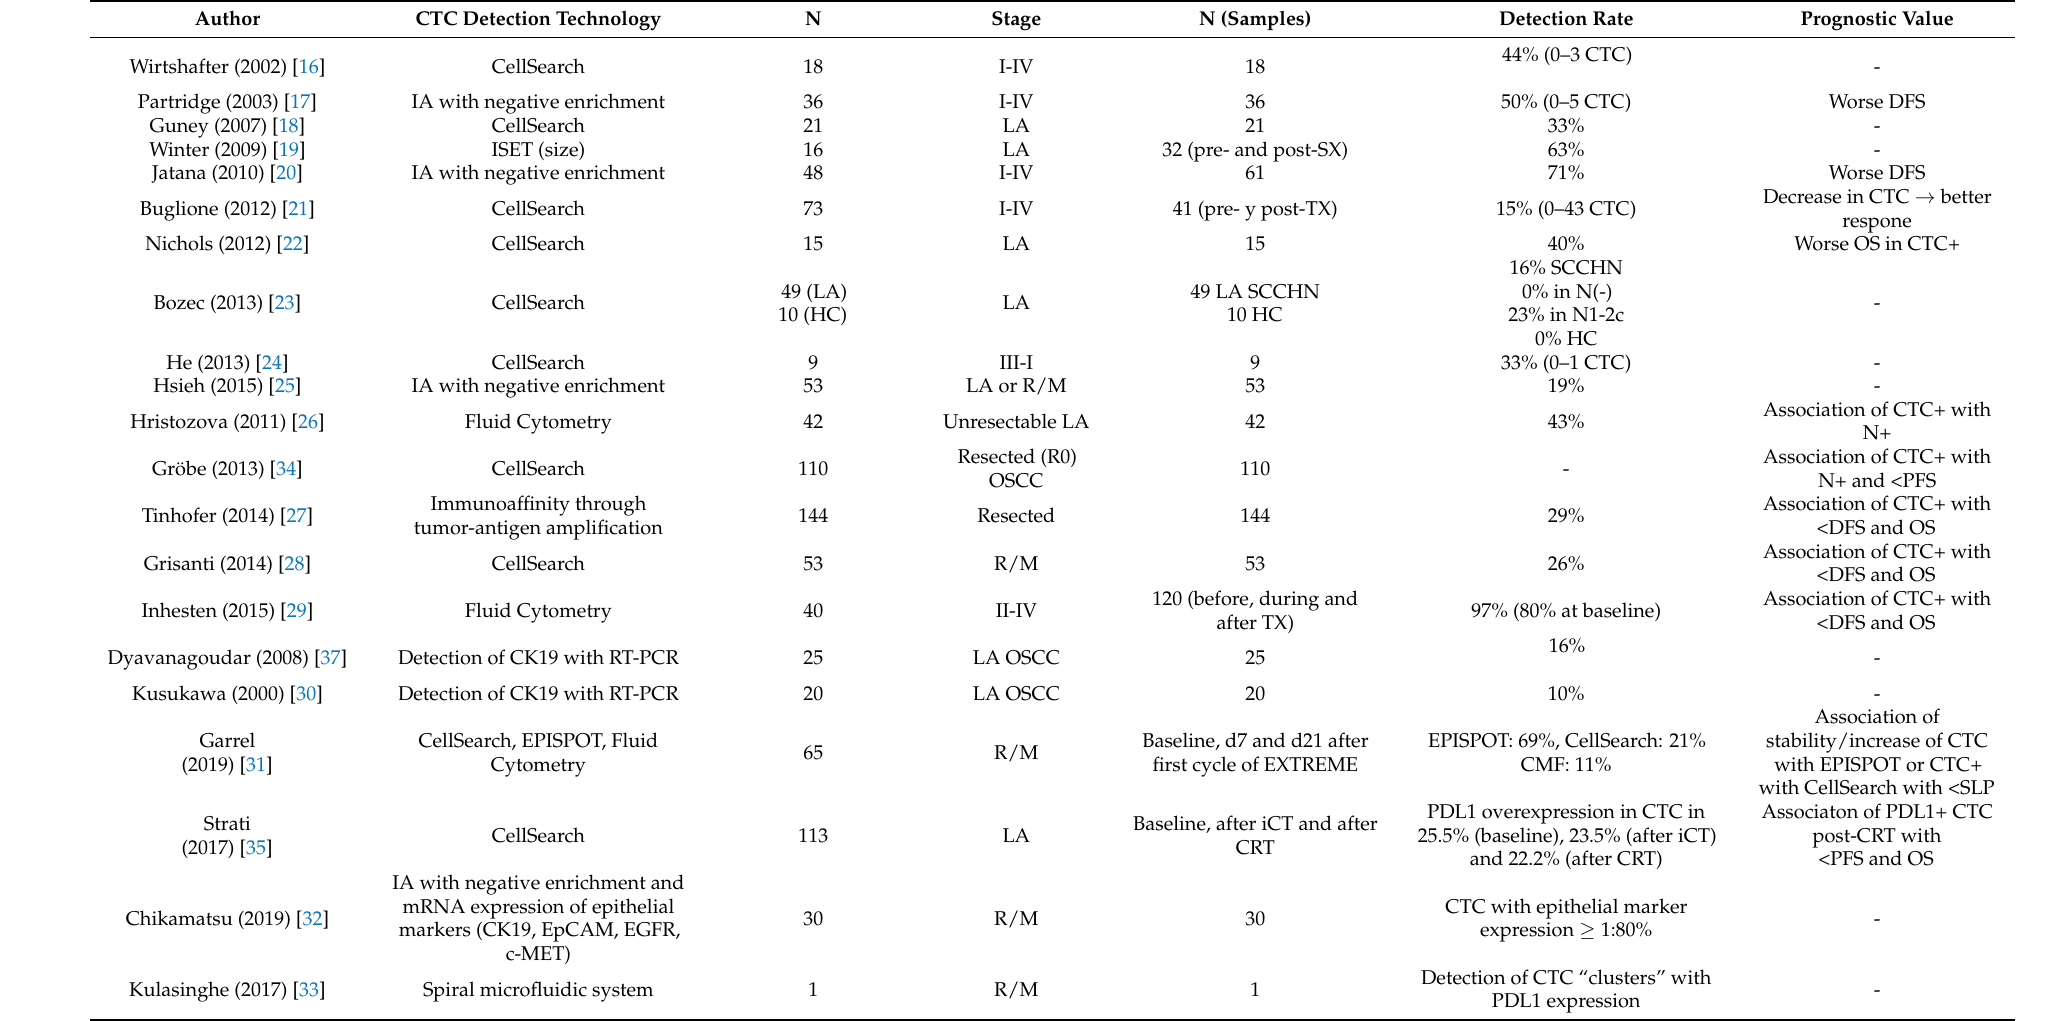
Table 1. Most relevant studies with CTC in patients with HPV-unrelated